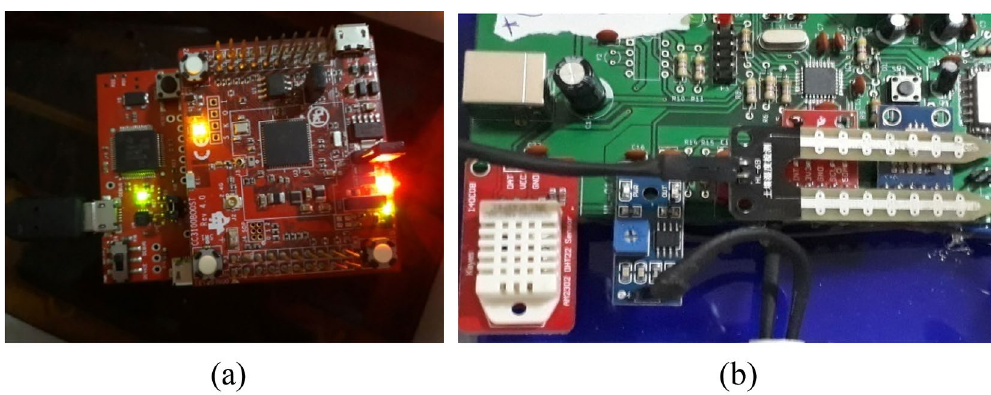
Figure 7. The hardware used in the validation test, ( a ) the base station, ( b ) a sensor node with a temperature and soil moisture